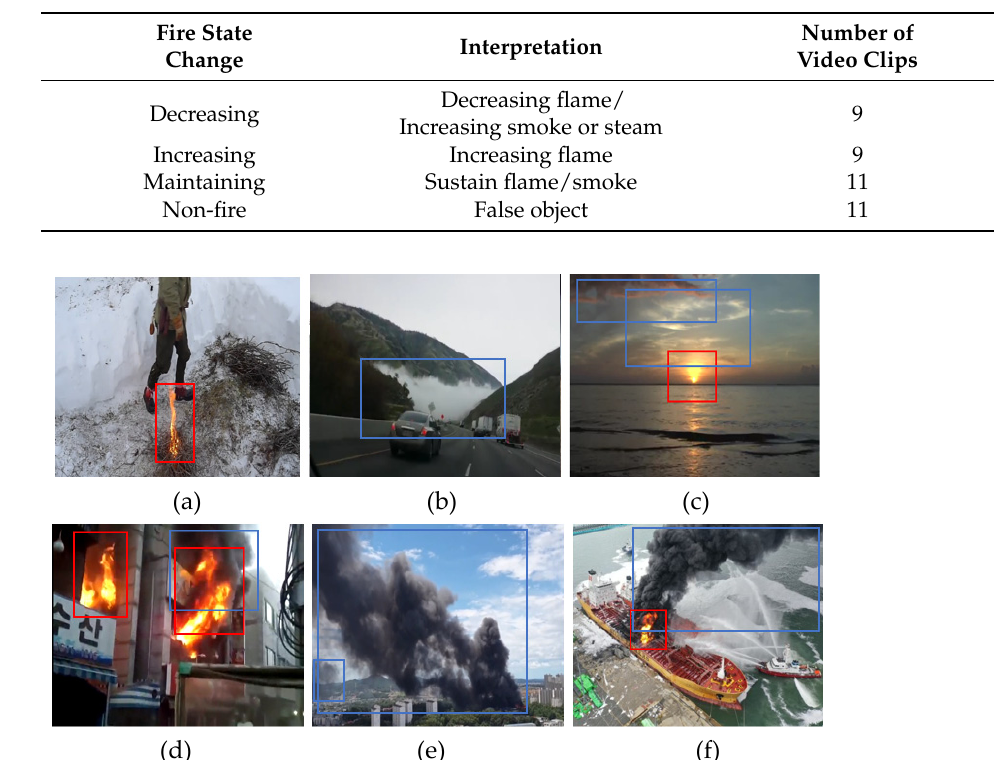
Figure 11. Bayesian network results for 6 cases [26]. The ( a ), ( d ), ( e ), and ( f ) images are taken from videos of fire, the ( b ) and ( c ) images are from non-fire video clips. Table 12. Changes in the probability of fire before and after Bayesian inference [26]. Case Fire(GT)